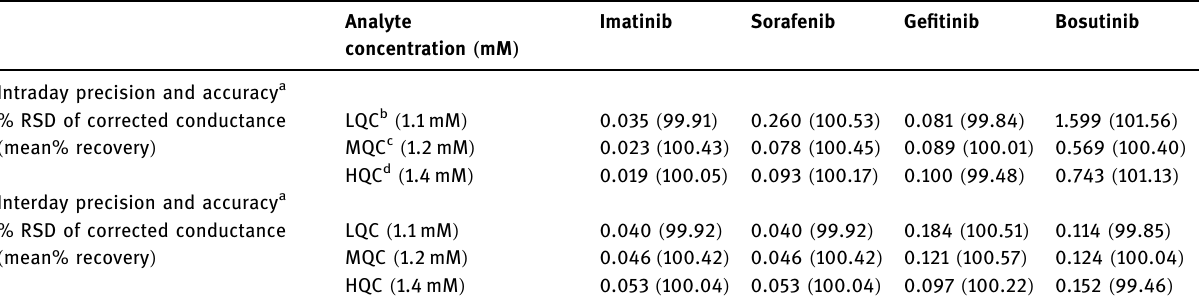
Table 2: Results of precision and accuracy of the developed conductometric method for imatinib, sorafenib, ge fi tinib and bosutinib analyzed at low, intermediate and high concentration